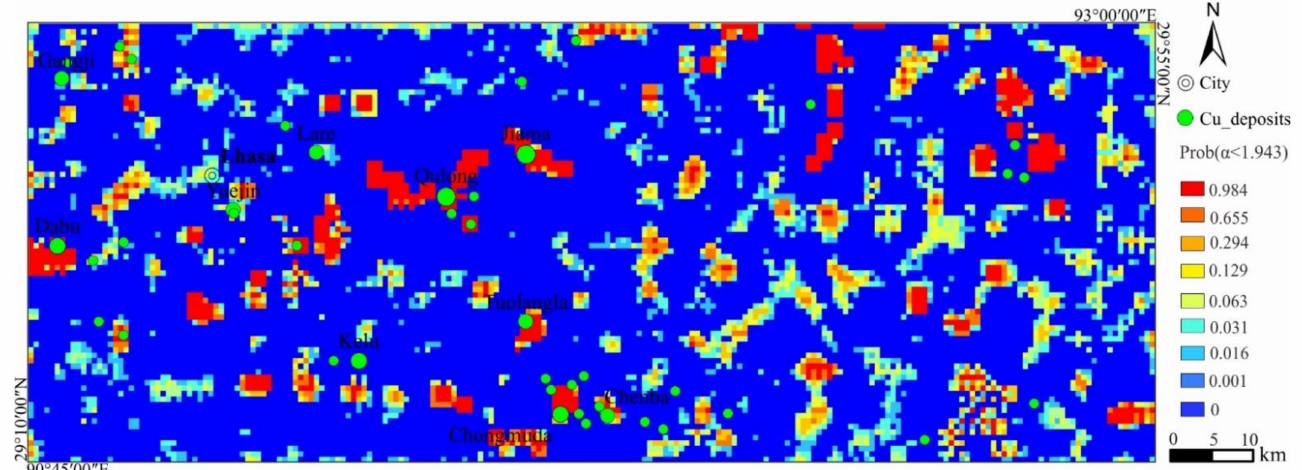
Figure 12. Probability maps of geochemical anomaly with α < 1.943.